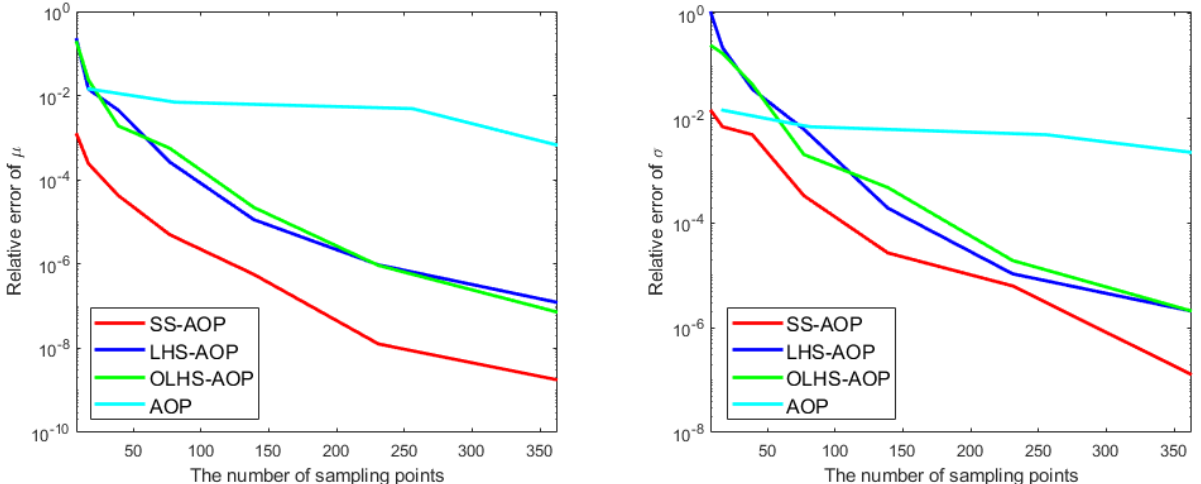
Figure 6. The relative error of mean value and variance for Case 4.